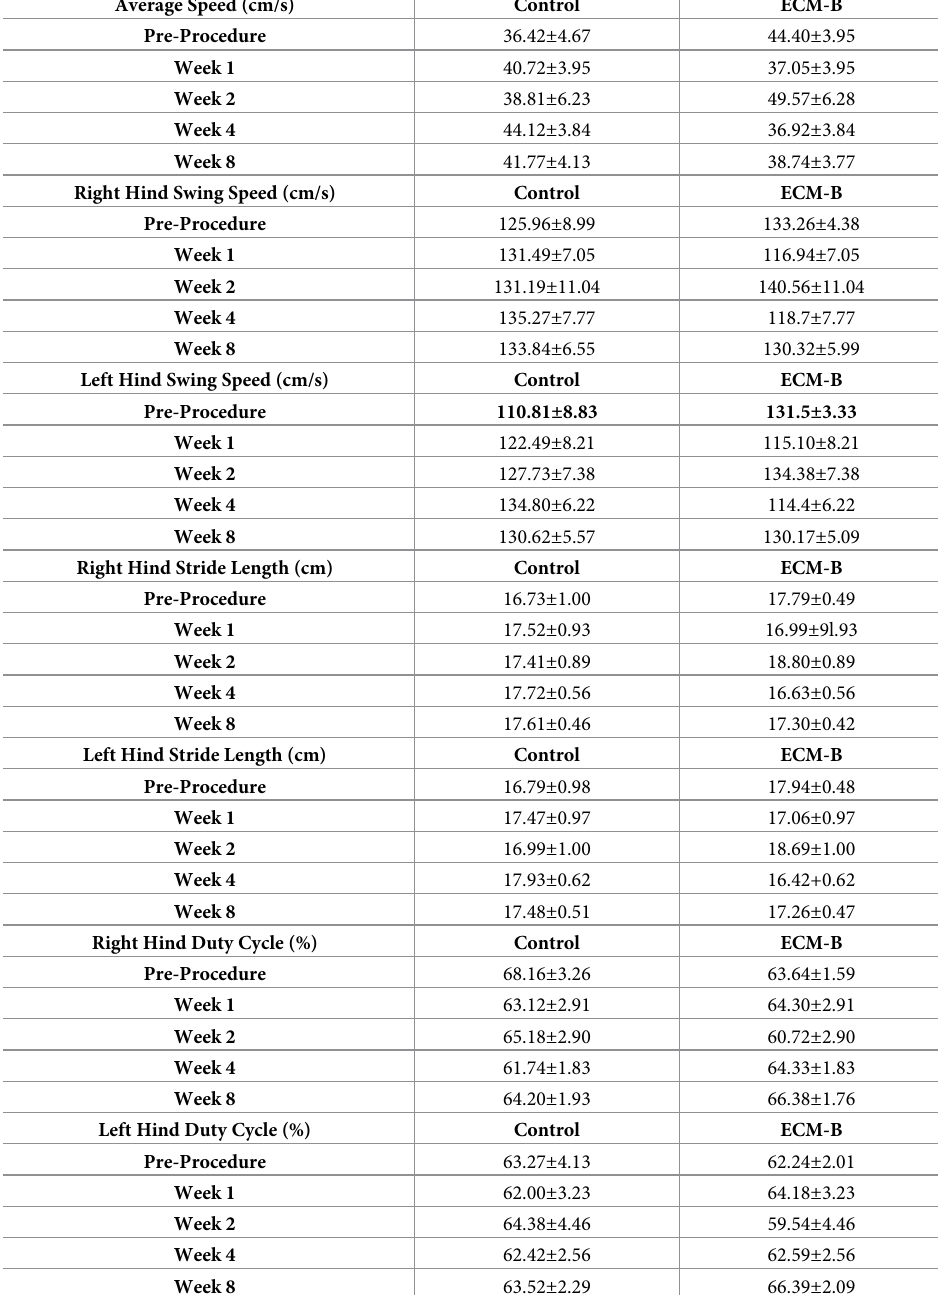
Table 2. Mean gait parameter value of each group at each time point with standard error. Significant P values (P adj. < .05) are bolded. Each group contains n = 5 animals except for week 8 ECM-B where n = 6. All values are pre- sented as the mean ± standard